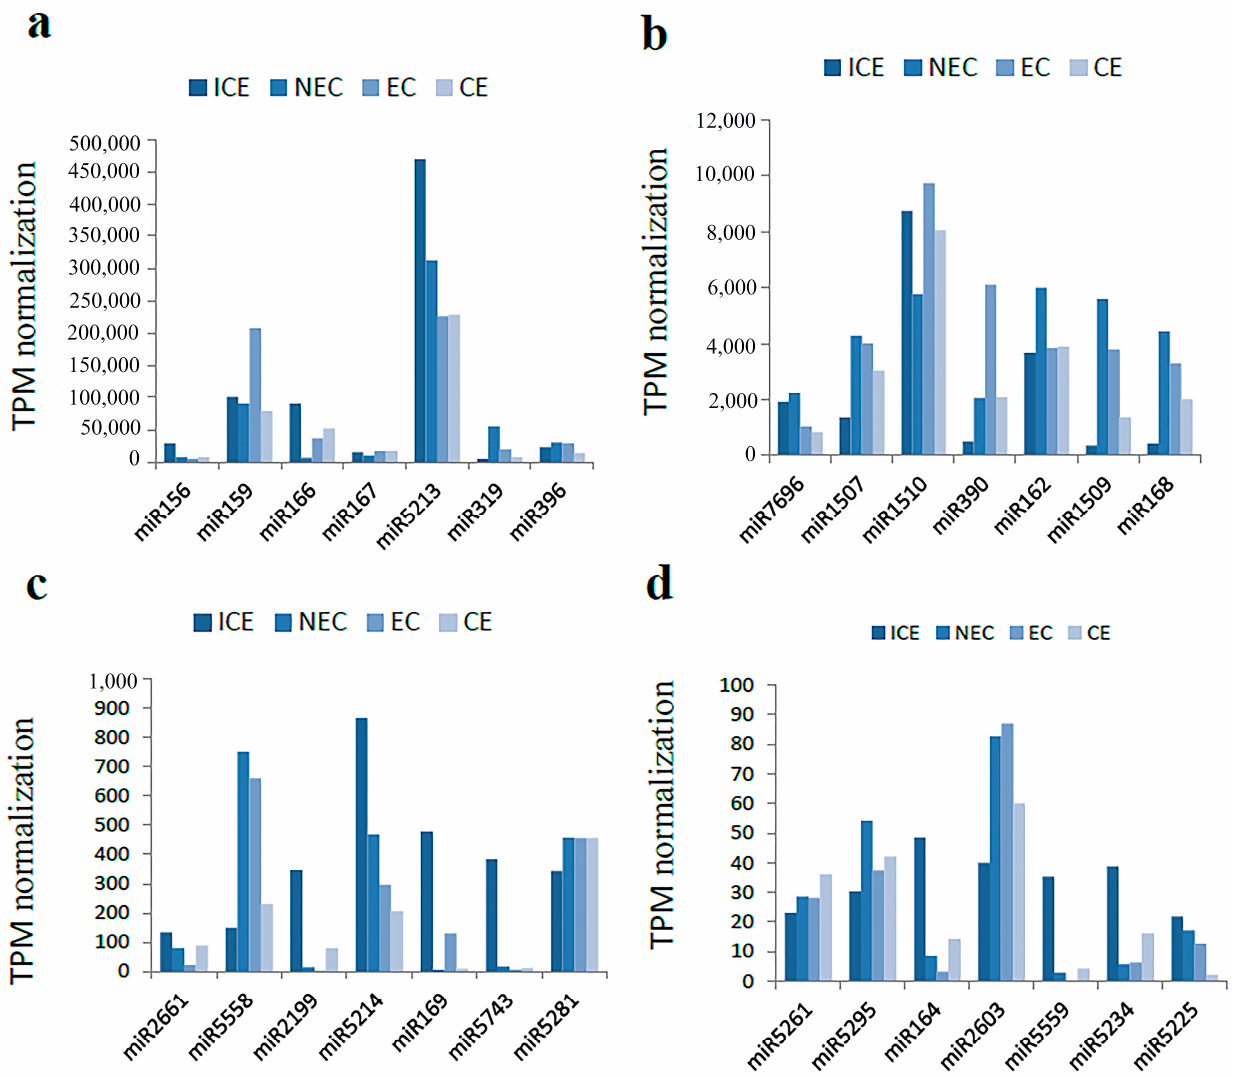
Figure 7. Transcripts reads per million reads known miRNAs in Medicago sativa . ( a ) miRNAs families with TPM value over 10,000; ( b ) miRNA families TPM value between 1000 and 10,000; ( c ) miRNA families TPM value between 100 and 1000; ( d ) miRNA families TPM value between 0 and 100.